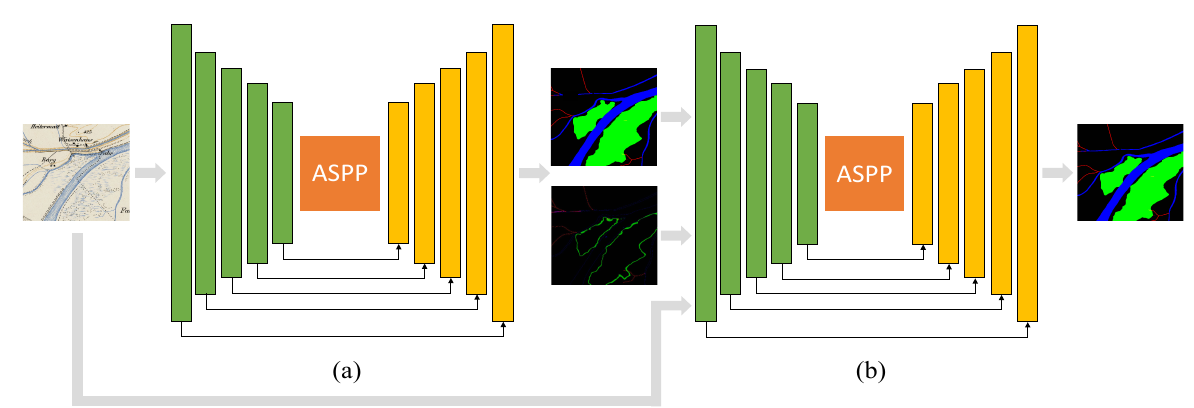
Figure 1. Our proposed two-stage architecture. In stage (a), a segmentation network (an ASPP-integrated U-Net) takes an input image and outputs a segmentation map. An uncertainty map is either output additionally by the network or calculated directly out of the segmentation map. In stage (b), a refinement network takes the segmentation map, uncertainty map and the input image from (a) to generate a refined prediction map. The network architecture stays the same.